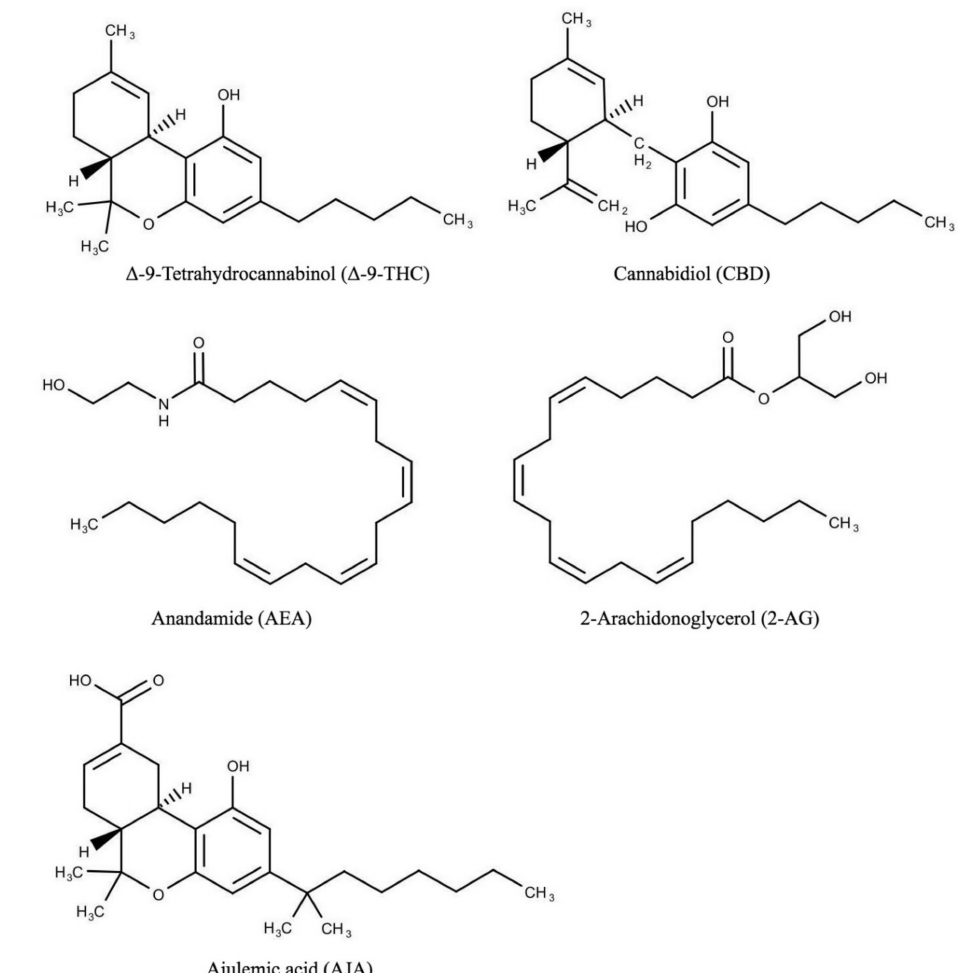
Figure 1. Structural formulae of main cannabinoids detailed in this